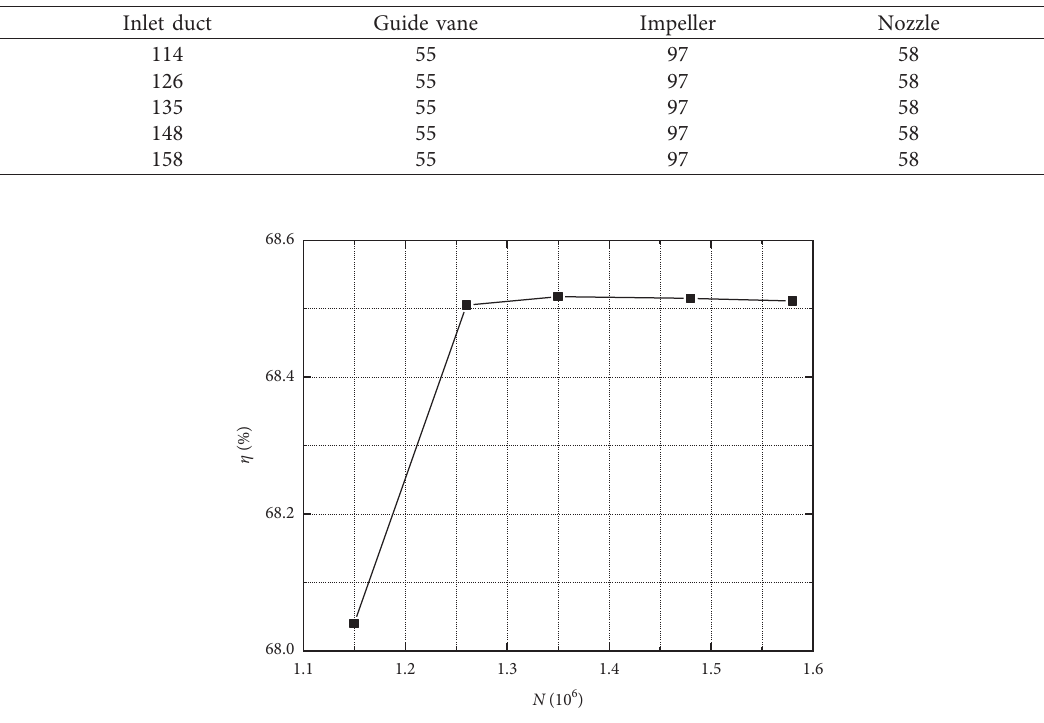
Figure 2: Hydraulic loss for different grid